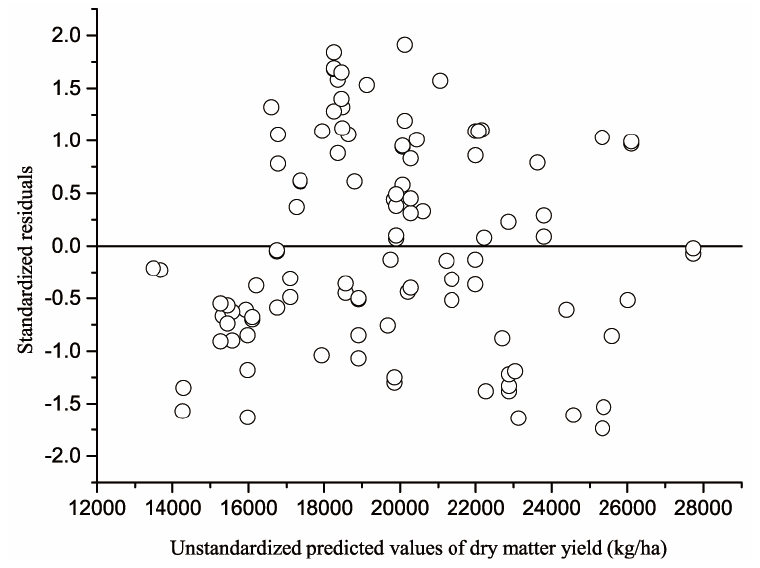
Figure 3. The scatter plot of standardized residuals against predicted values of the response variable from the constructed sorghum–sudangrass hybrid yield prediction model.